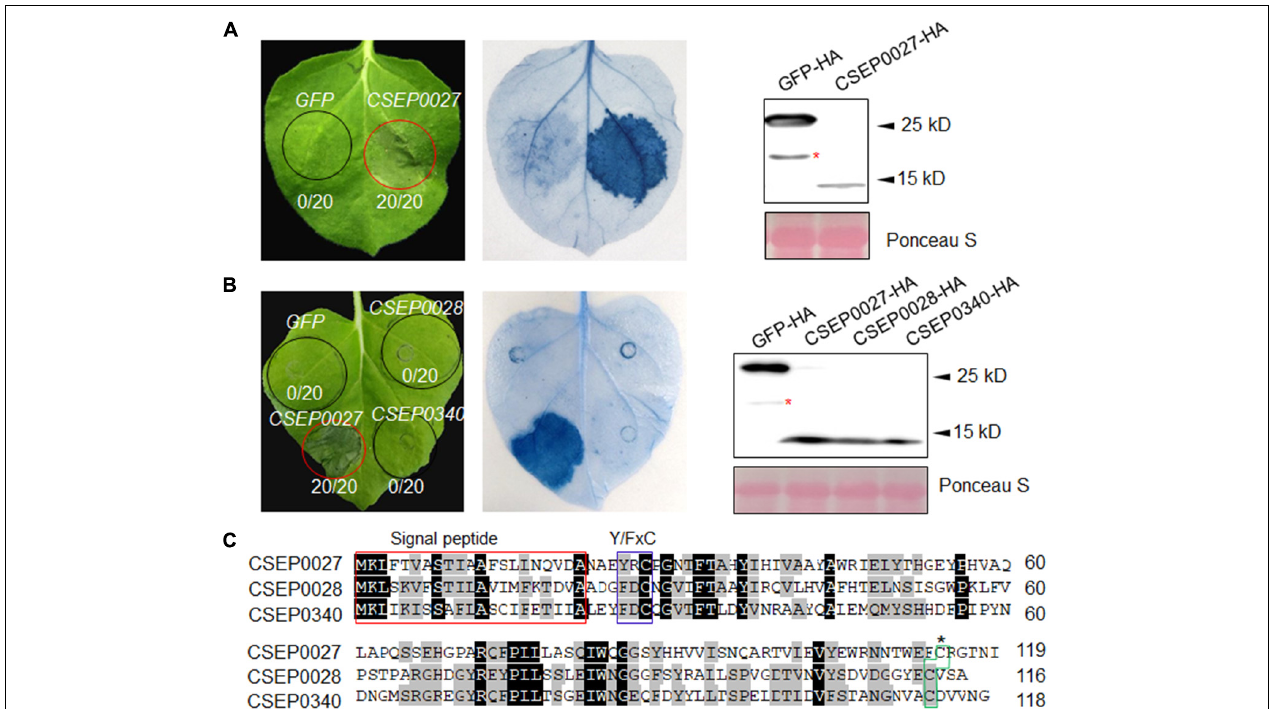
FIGURE 1 | CSEP0027 triggers cell death in Nicotiana benthamiana . (A) Expression of CSEP0027 triggers cell death in N. benthamiana . Agrobacterium tumefaciens was used to transiently express CSEP0027 or GFP in N. benthamiana leaves. The picture was taken at 5 dpi, and cell death was visualized by trypan blue staining. The numbers in each circled area indicate numbers of cell death in total number of leaf areas infiltrated with the construct. Total protein extract was obtained from N. benthamiana leaves at 60 hpi and protein expressions were confirmed by immunoblotting using anti-HA antibody. Ponceau staining was used to show equal loading. (B) CSEP0028 and CSEP0340 do not trigger cell death in N. benthamiana . The experimental procedures are the same as in (A) . The stars in the Western blots in panels (A,B) indicate non-specific signals. (C) Sequence alignment of CSEP0027, CSEP0028, and CSEP0340, performed using the DNAMAN software. The